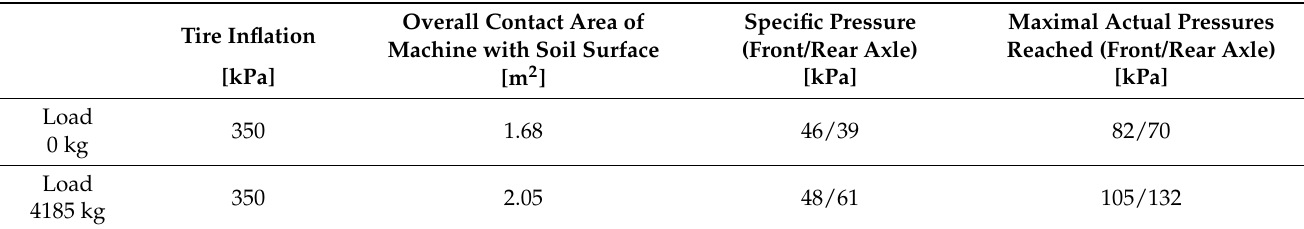
Table 2. Specific pressures of a wheeled forwarder with tracked wheels on the soil surface and actual pressures at a soil profile depth of 15 cm.